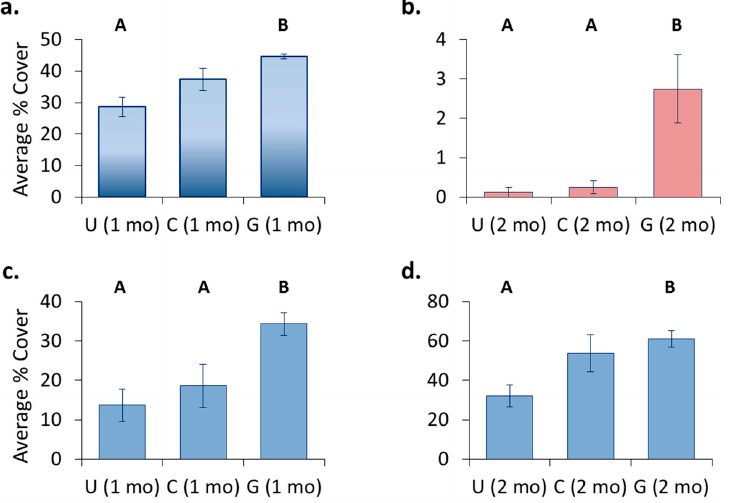
Figure 13. Differences in fouling due to prior husbandry, groomed dominance. ( a ) Macrofouling cover on IS700 at Sebastian in August was significantly higher on groomed than on uncleaned pan- els ( p = 0.004). ( b ) Cover of barnacles on IS700 at Sebastian in September was significantly higher on groomed than on uncleaned and cleaned panels ( p < 0.05). ( c ) Cover of hydroids on IS700 at Sebas- tian in August was significantly higher on groomed than uncleaned and cleaned panels ( p = 0.007). ( d ) Cover of hydroids on 3140 at Sebastian in September was significantly higher on groomed than on uncleaned panels ( p = 0.017). The X-axes are treatments; the Y-axes are average percent cover. Please note that Y-axes vary. Treatments are uncleaned (U), cleaned (C) and groomed (G). The time in the parenthesis is elapsed time since cleaning and transplant. Letters above the bars denote sta- tistical significance (i.e., As are statistically similar to, but significantly different than, Bs). 4. Discussion This research has shown that hull husbandry practices affect fouling community composition. Grooming maintains surfaces at a low level of macrofouling, with biofilms occupying most of the exposed surface. Uncleaned and cleaned surfaces collected more types and higher cover of macrofouling. This is in line with a previous study which found that ungroomed silicone began to accumulate macrofouling after 78 days whereas fre- quent grooming was able to maintain silicone panels with low levels of biofilm for 120 days, when the experiment was ended [44]. Although the research presented here was short-term, previous research has shown the long-term efficacy of grooming in maintain- ing surfaces free of macrofouling, albeit using a different grooming tool [17,44,45,52]. Unlike grooming, cleaning did not affect fouling community structure or percentage of cover greatly when compared with the uncleaned freely fouling treatment. On the two commercial coatings, dissimilarity between cleaned and uncleaned surfaces was low and only increased when panels had been cleaned one month prior to sampling. On DC3140, the cleaned and uncleaned surfaces were more than 50% dissimilar in June, one month after panels had been cleaned, and only 40% dissimilar in July, when the uncleaned panels had 4 months of accumulated fouling and the cleaned ones had 2 months’ accumulation. Except for June IS700, when cleaned and groomed surfaces were relatively similar, groomed panels were always less similar to uncleaned and cleaned panels than they were to each other. More specifically, uncleaned panels were significantly more fouled than